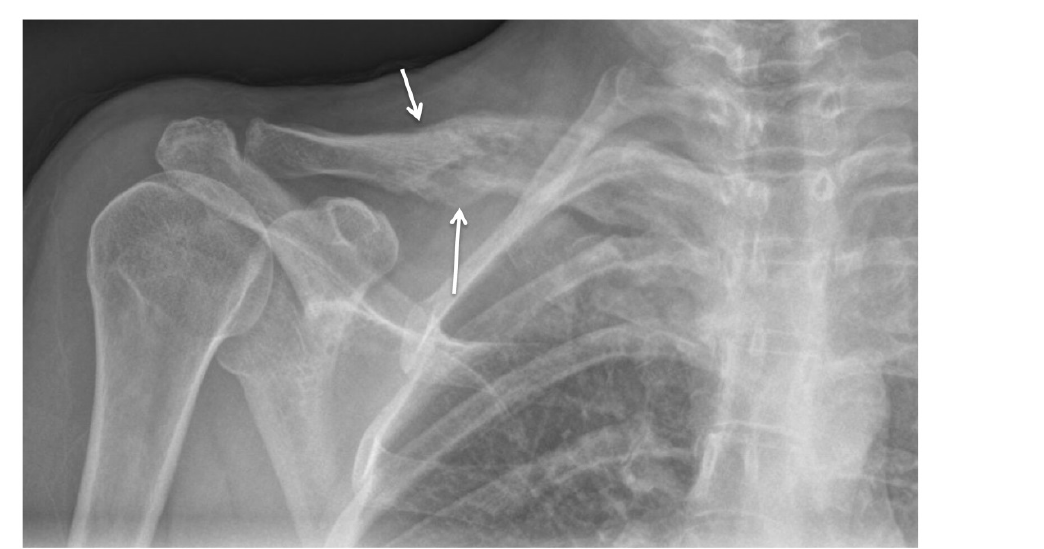
Figure 2. AP plain film demonstrates interval development of mixed lucent (long arrow) and sclerotic (short arrow) changes of the mid clavicle, with periosteal reaction that is fairly smoothly